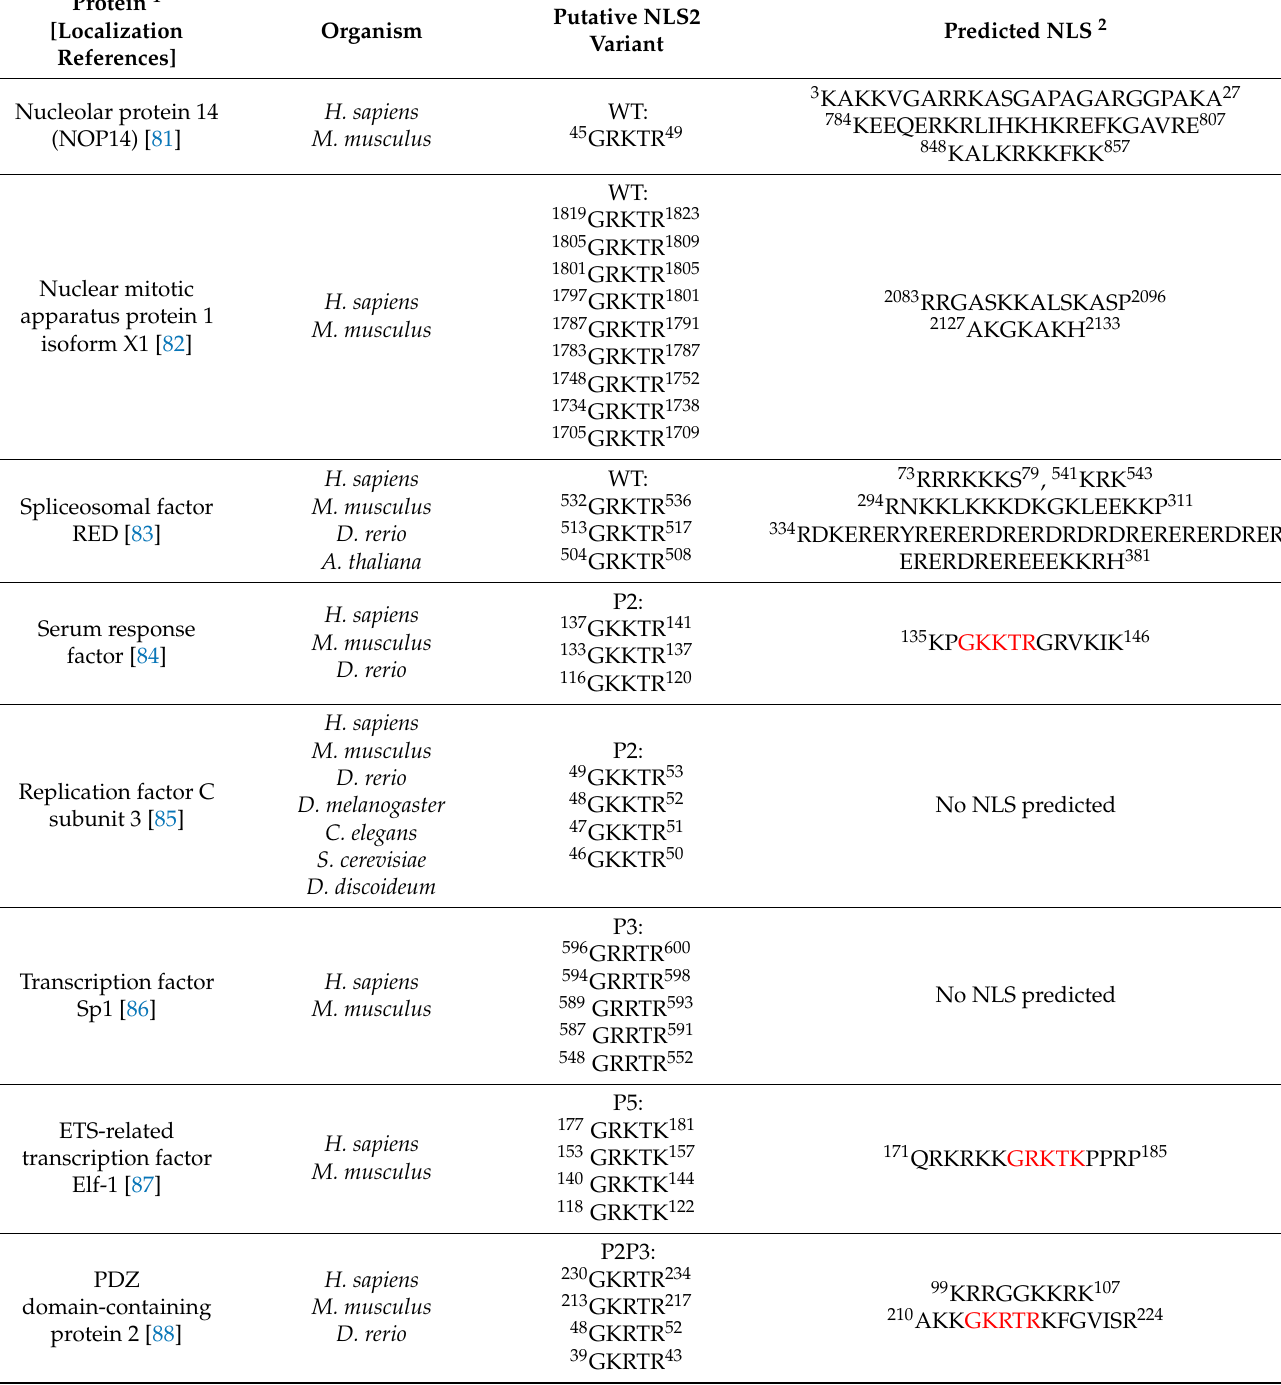
Table 4. Human nuclear proteins containing GRKTR variants found in one or more other organisms and their predicted